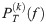
Normalized Lomb power spectrum PT(k)(f) for each averaged pollutant concentration time series x(k).